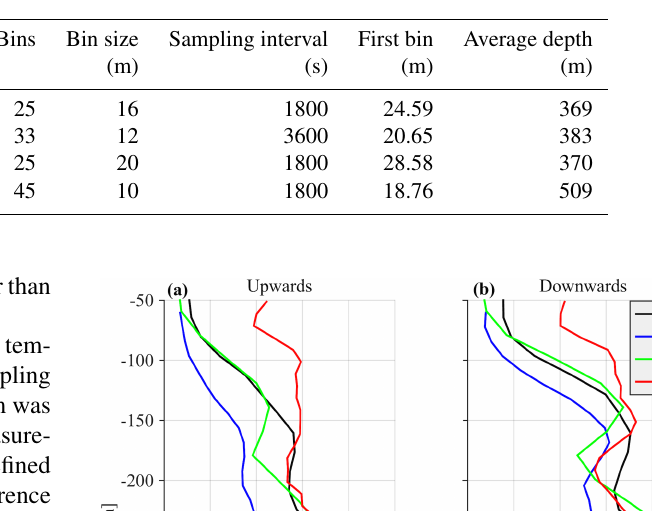
Table 1. The deployment parameters of the upward looking 75kHz RDI ADCP on the subsurface mooring line of E1-M3A.